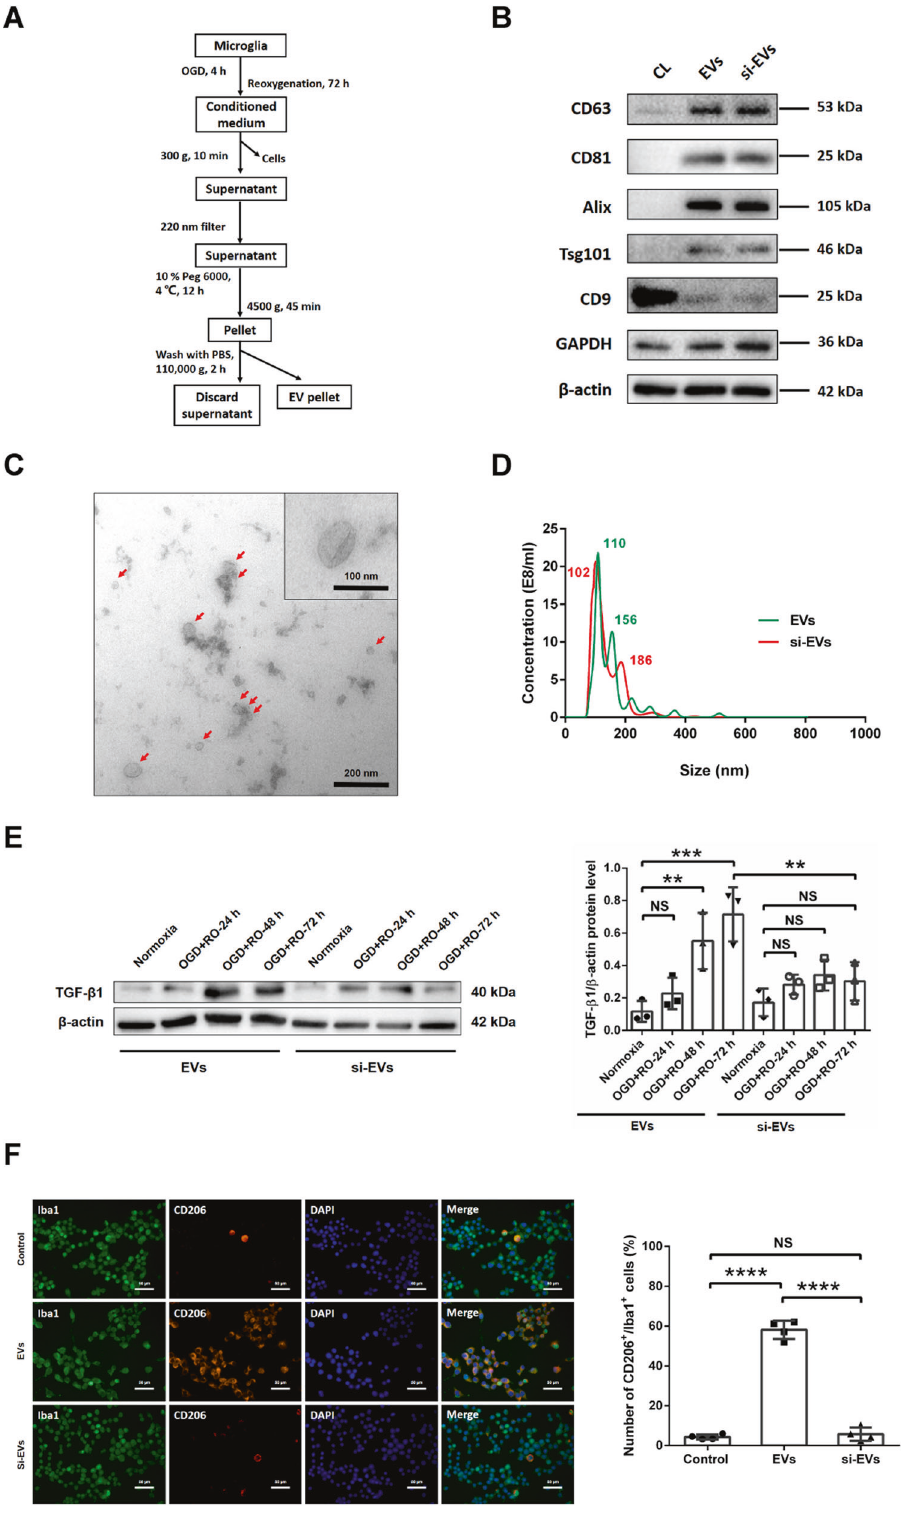
means of TUNEL staining con fi rmed the Western blot results, i.e., EVs from OGD-preconditioned microglia but not si-EVs signi fi - cantly reduced apoptotic cell injury (Fig. 4D, E). The in vitro experimental paradigm on bEnd.3 cells and cortical neurons were stated in Supplementary Fig. II